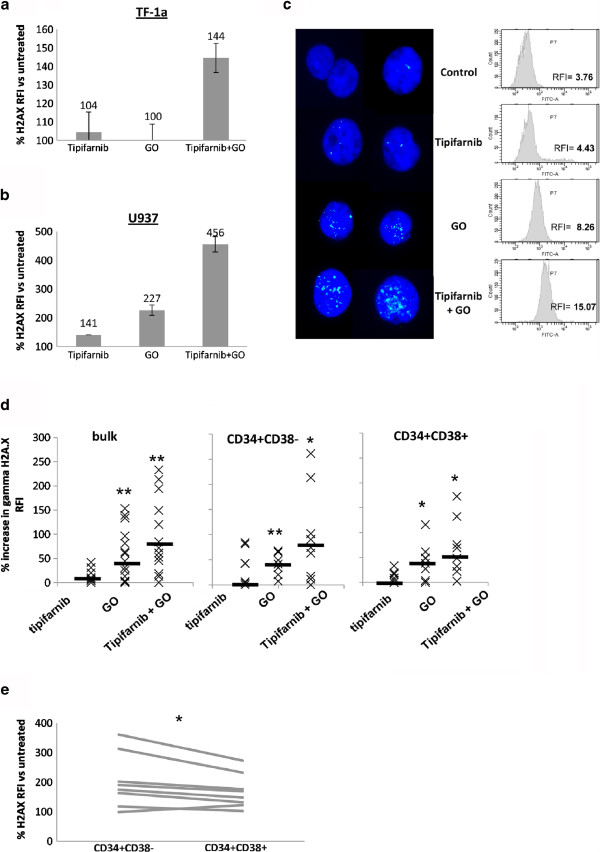
γH2AX in treated cells. Cells were treated with 10 ng/ml GO, 5 μM tipifarnib or the combination for the indicated times. FACs data are expressed as γH2AX test – isotype control fluorescence intensity compared to untreated cells. (a,b) Summary charts for TF-1a and U937 cells respectively cells after 48 hours’ treatment (c) Illustration of immunofluorescence and FACs plots showing increases in focal (immunofluorescence) and total (flow cytometry) γH2AX following 24 hours of treatment in U937 cells. (d) Summary charts of flow cytometric values for primary AML: bulk (n = 14); CD34+CD38- (n = 9); CD34+CD38+ (n = 8). Median values are shown by a solid bar. * represents a P value compared with untreated cells of <0.05 and ** represents P < 0.01. (e) Line graph showing γH2AX induction in CD34+CD38- cells compared to CD34+CD38+ cells in each of 8 samples